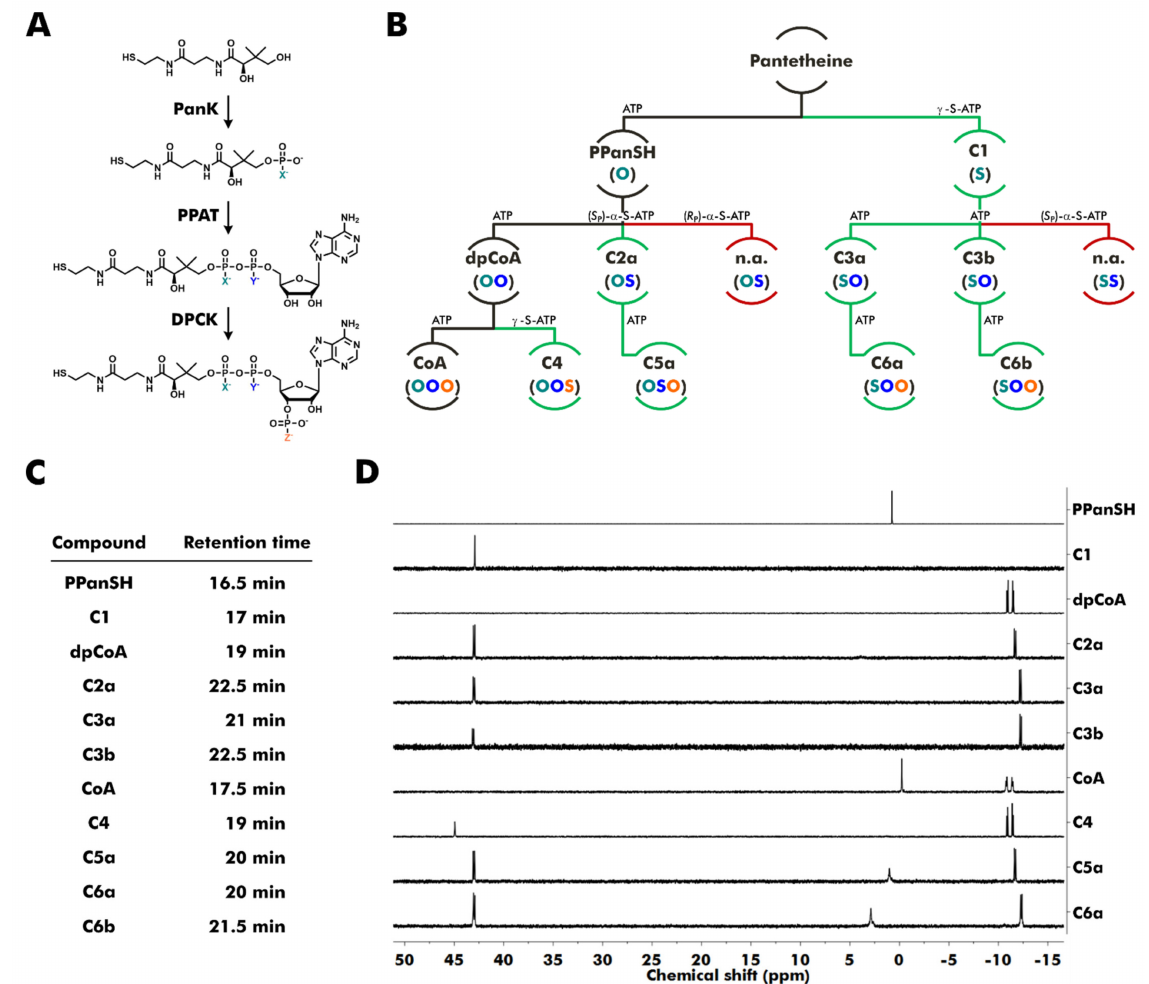
Figure 1. Synthesis of thiophosphate analogs of PPanSH, dpCoA, and CoA starting from pantetheine. ( A , B ) Reaction scheme for CoA and CoA thiophosphate analogs. The phosphorylation catalyzed by E. coli pantothenate kinase (PanK) yields PPanSH or a thiophosphate analog of PPanSH. The AMP transfer catalyzed by E. coli phosphopantetheine adenylyltransferase (PPAT) yields dpCoA or thiophosphate analogs of dpCoA. The phosphorylation catalyzed by E. coli dpCoA kinase (DPCK) yields CoA or thiophosphate analogs of CoA. ( B ) Colored letters in parentheses show the type of atom (oxygen or sulfur) in position X, Y, or Z of the respective compound shown in ( A ). Path descriptions display whether ATP or a thiophosphate analog of ATP was used to produce the respective compound. Black lines show the canonical path. Green lines show the paths to accessible novel products. Red lines show the paths to inaccessible products (n.a.: not accessible). ( C ) Approximate retention times of compounds during purification by reversed-phase high-performance liquid